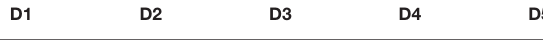
TABLE 7 | Results for the average reaction time and standard deviation per IPD. The average reaction time for all the IPDs is M = 4.92 s , SD = 1.03. D1 D2 D3 D4 D5 4.96 s (1.08) 4.94 s (1.23) 4.88 s (0.79) 4.92 s (1.07) 4.92 s